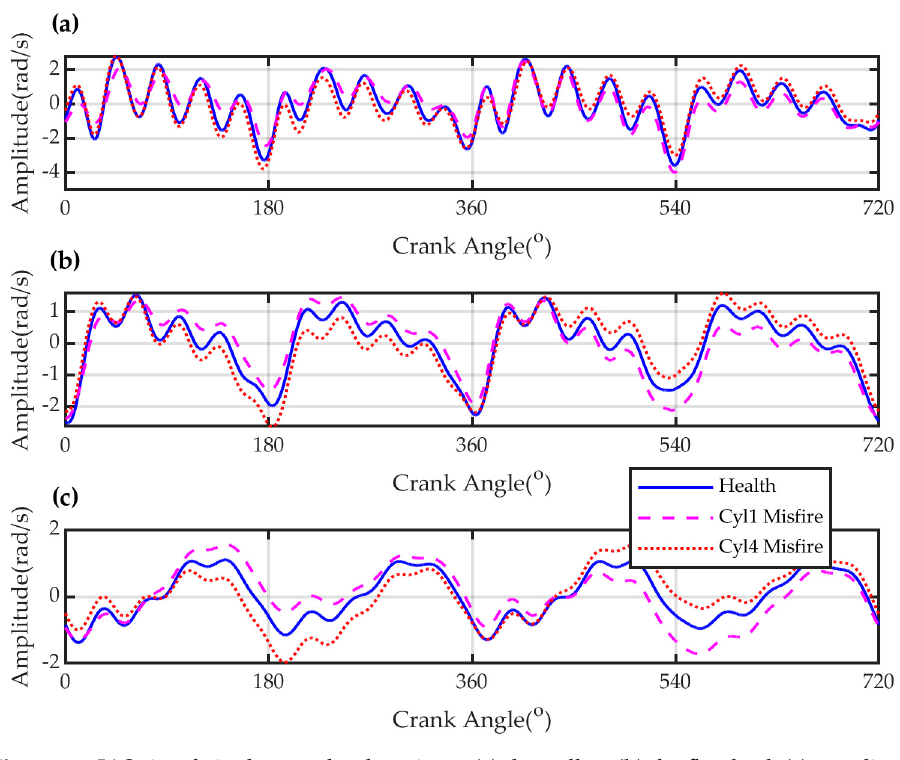
Figure 10. IAS signals in the angular domain at: ( a ) the pulley; ( b ) the flywheel; ( c ) coupling.